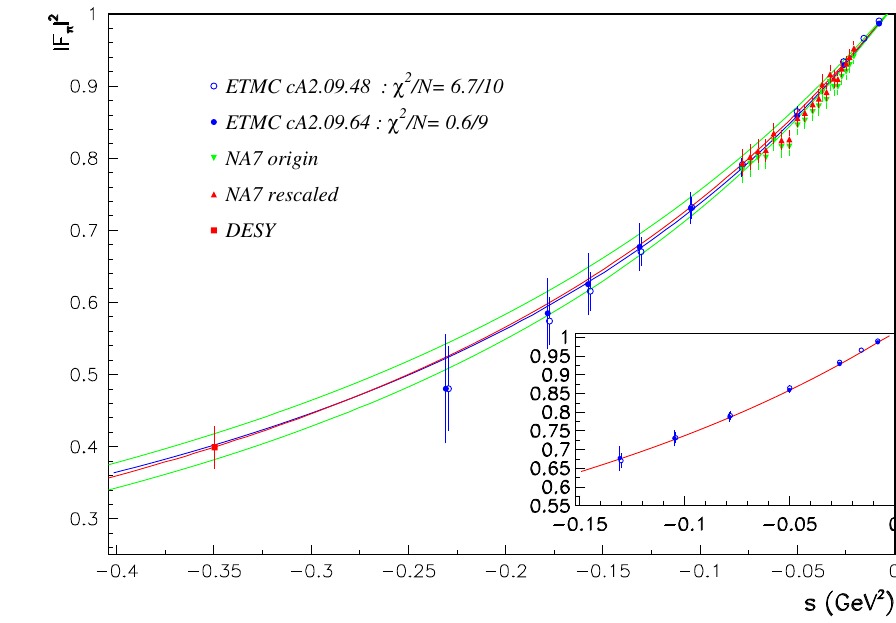
ETMC cA2.09.48 : χ 2 /N= 6. 7